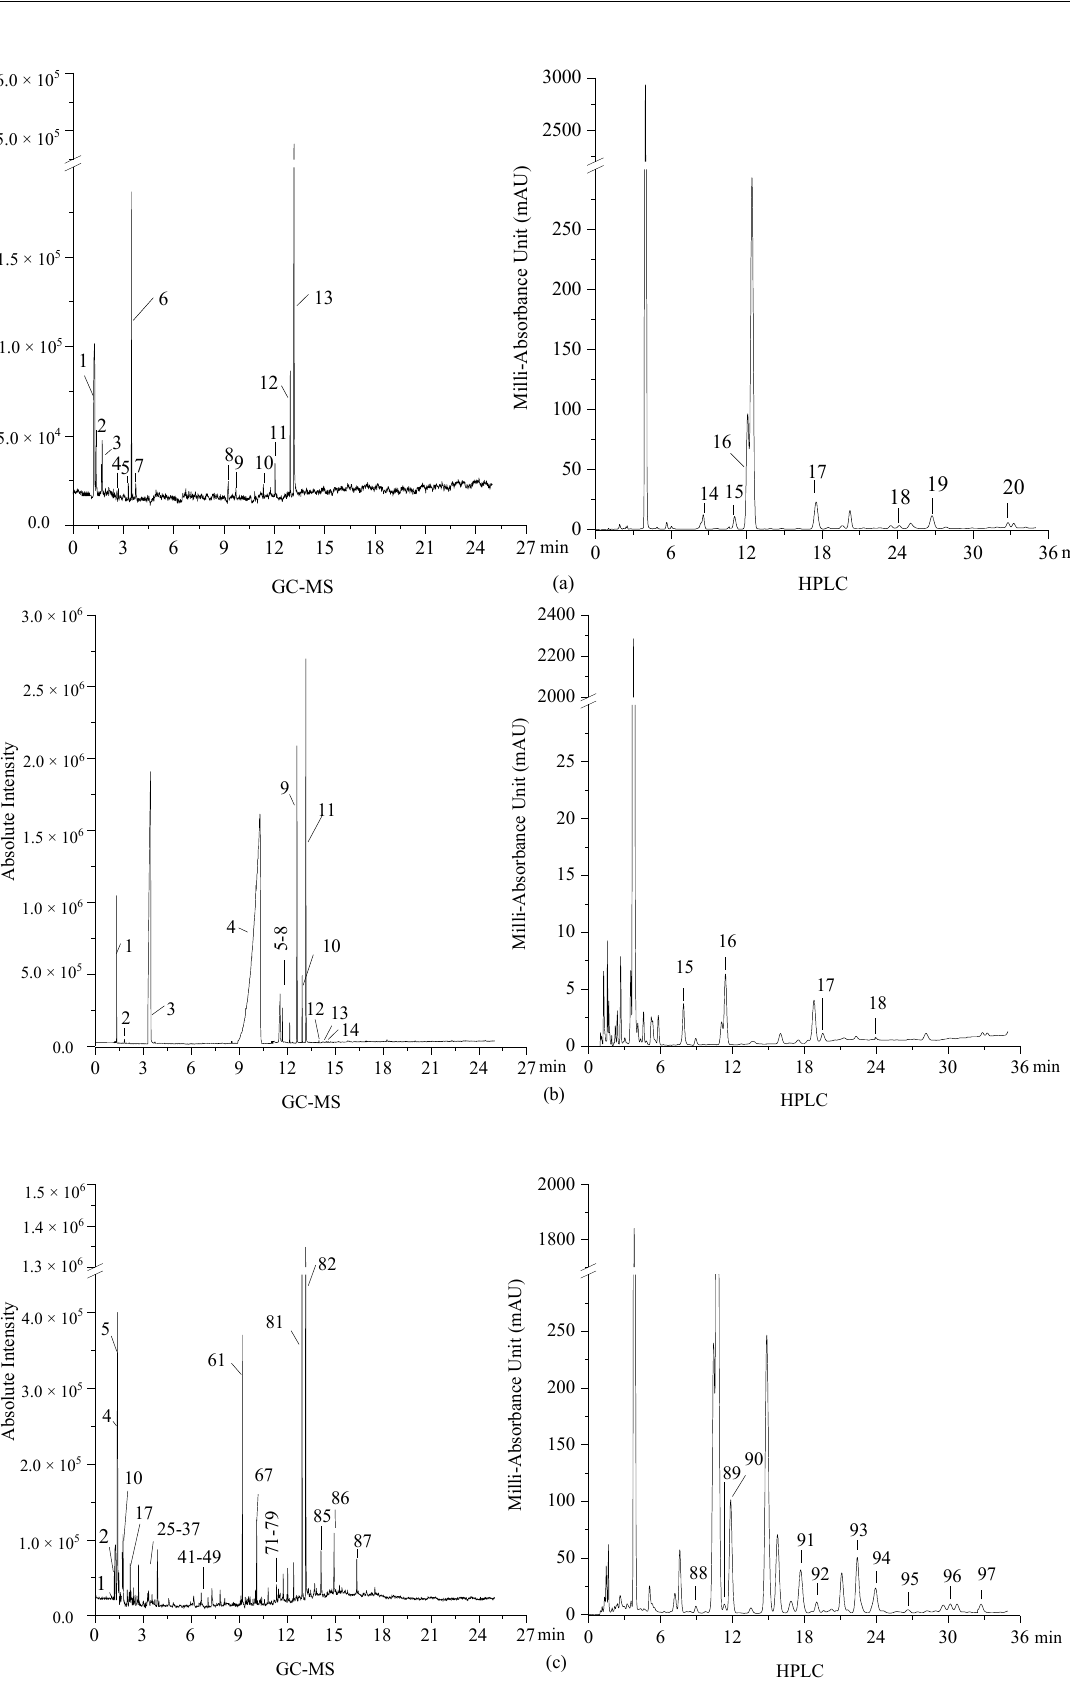
Figure 2. GC-MS and HPLC chromatograms of the VOCs emitted by HTPs ( a ), e-cigarettes ( b ) and cigarettes ( c ).